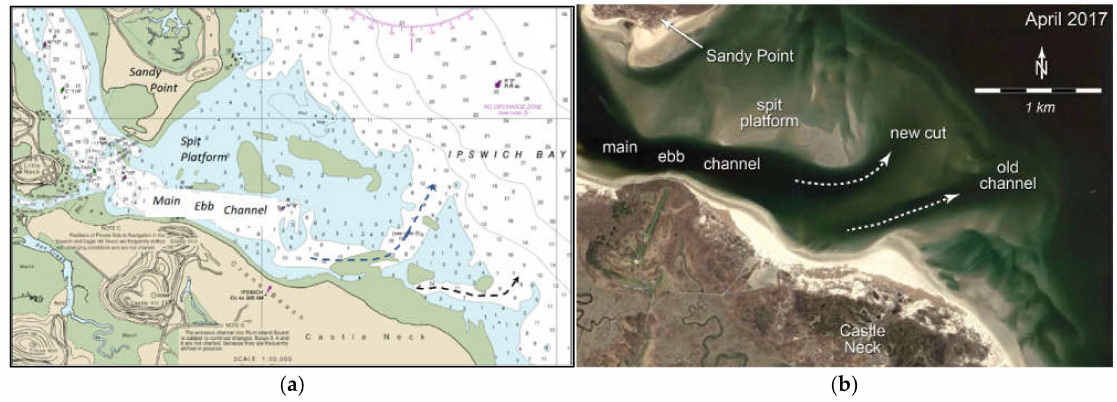
Figure 8. Process of ebb-tidal delta breaching [30] for ( a ) 1969 and ( b ) 2017. The new channel cut provides a more direct route for tidal exchange and increases hydraulic connectivity between Plum Island Sound and the coastal ocean. The 1969 chart is NOAA Chart 13274. The 2017 imagery is from